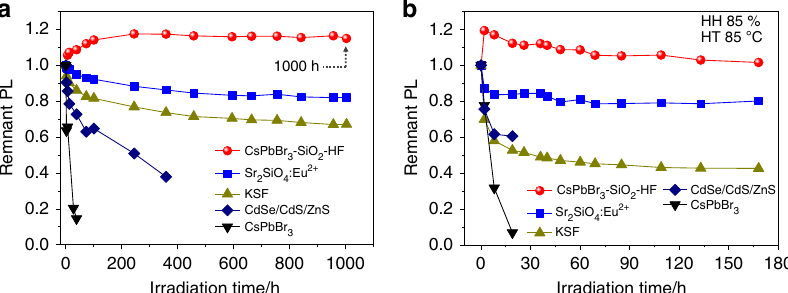
Fig. 6 Photostability of the CsPbBr 3 – SiO 2 – HF. a Photostabilities of the CsPbBr 3 – SiO 2 – HF, ceramic Sr 2 SiO 4 : Eu 2 + green phosphor, KSF red phosphor, colloidal CsPbBr 3 NCs and CdSe/CdS/ZnS NCs under illumination, sealed with Norland-61 on the LED chips (20 mA, 2.7 V) and b aged at 85 °C and 85% humidity conditions on the LED chips (20 mA, 2.7